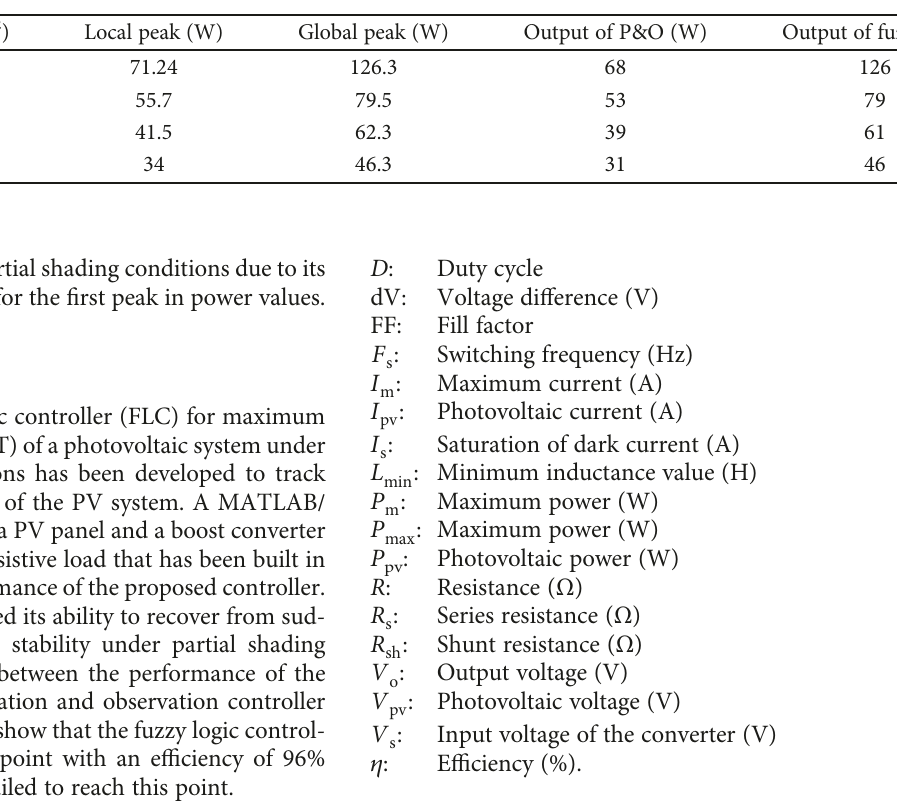
Table 5: Comparison between the fuzzy controller and